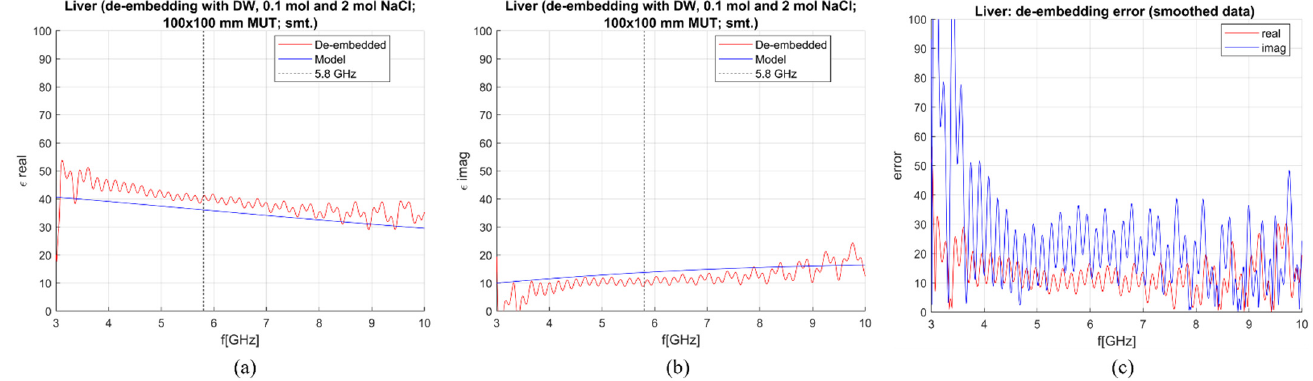
Figure 8. S&S de-embedding with the 2nd calibration option: DW, 0.1 mol and 2 mol NaCl (smoothing applied): ( a ) Calculated vs. reference ε ’; ( b ) calculated vs. reference ε ’’; ( c ) sensitivity (de-embedding error) for ε ’ (“real”) and ε ’’ (“imag”).